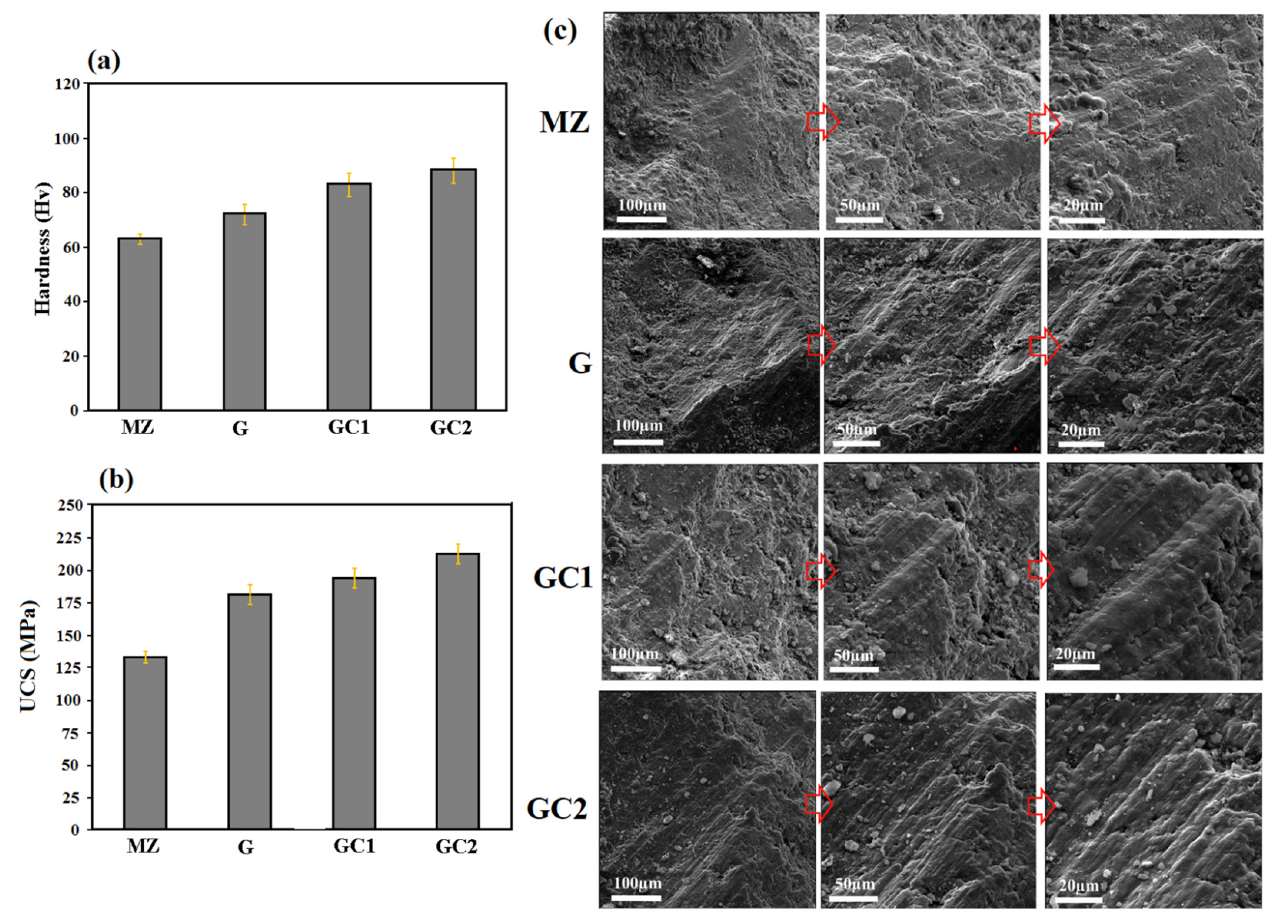
Figure 6. ( a ) Microhardness value, ( b ) Ultimate compressive strength (UCS) value of MZ, MZ/GO (G), MZ/1GO-Cu (GC1), and MZ/2GO-Cu (GC2) composites, and ( c ) SEM images of fracture surfaces of MZ, MZ/GO (G), MZ/1GO-Cu (GC1), and MZ/2GO-Cu (GC2) composites after compression testing.